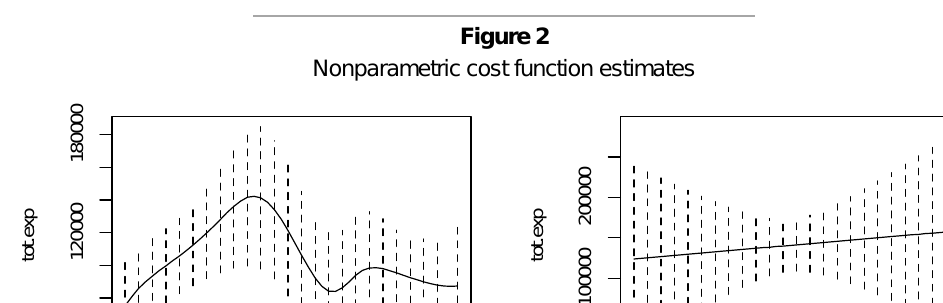
Nonparametric cost function